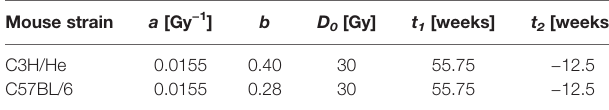
TABLE 1 | Parameters for the dose-volume response model for irradiated brain subvolumes of C3H/He and C57BL/6 mice.